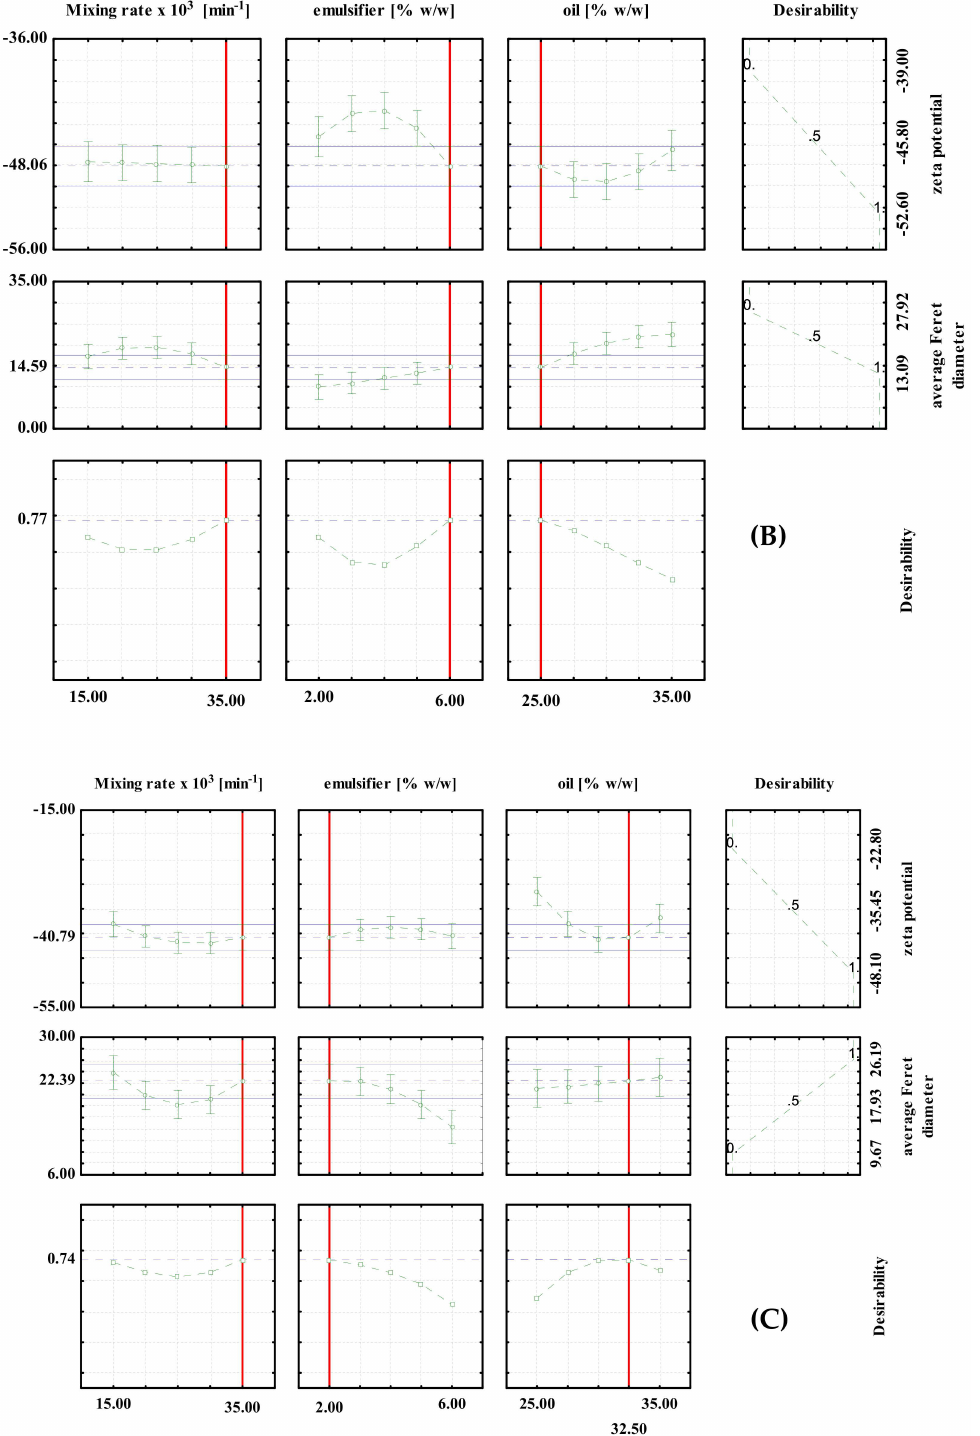
Figure 2. Desirability profiles for batch experiments with: ( A ) PEG1500; ( B ) PEG6000; ( C )